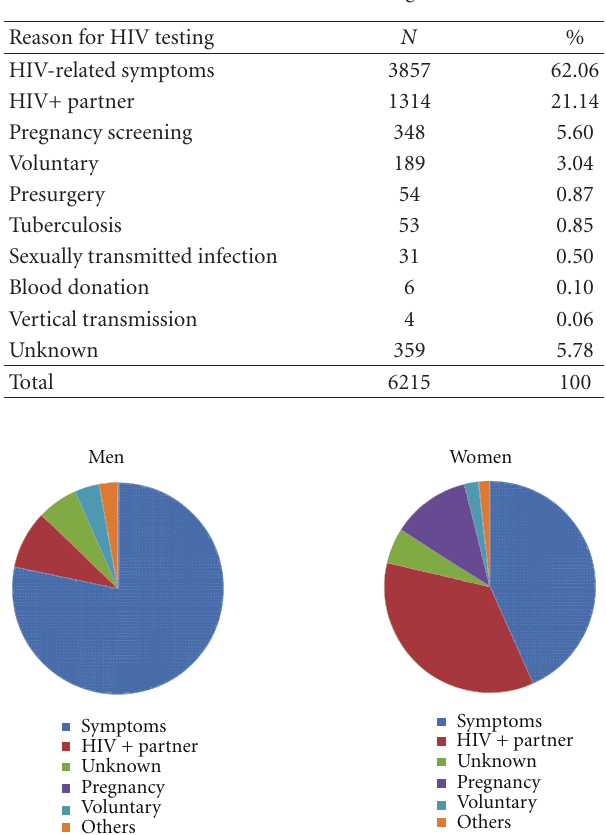
Table 1: Reasons for HIV diagnosis.